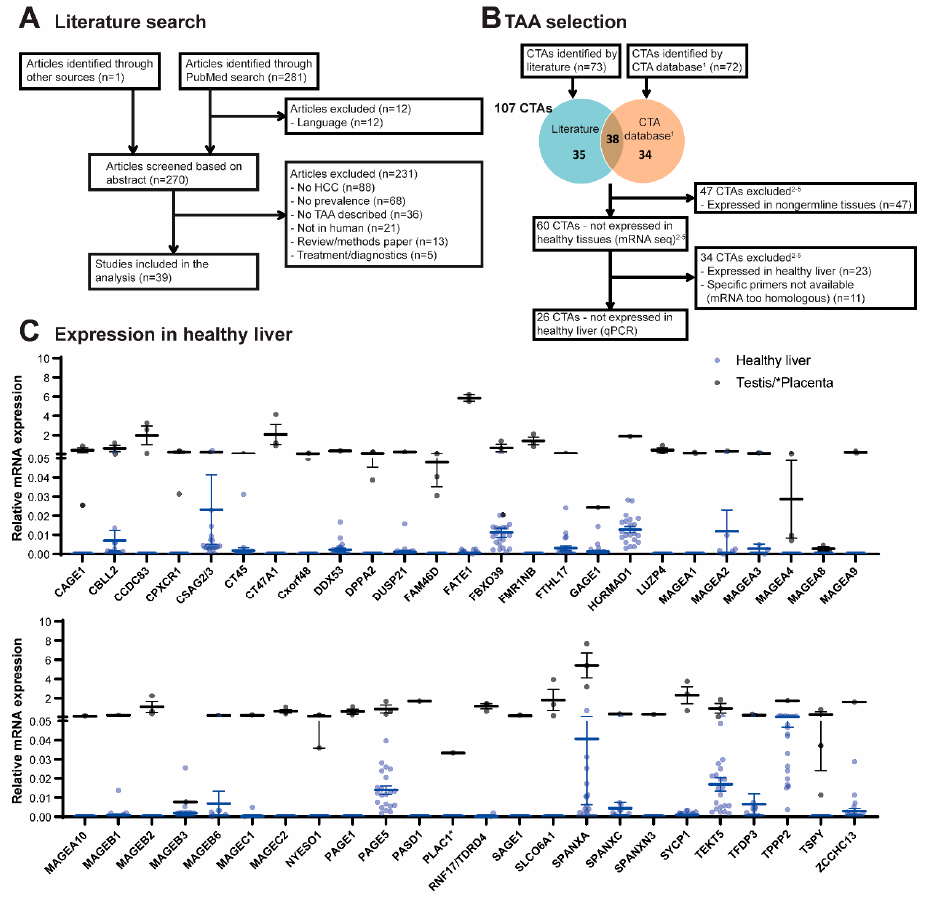
Figure 1. Selection of CTAs. ( A , B ) Study Flow Diagram. ( C ) Relative mRNA expression of selected CTAs in healthy donor livers ( n = 21) in blue and in the respective positive control tissues in black. Control tissues were: placenta (for PLAC1; n = 1) or testis (all other CTAs; n = 1–3). 1 http://www.cta.lncc.br/ 4 October, 2018, 2 Hofmann, et al. 3 FANTOM consortium, 4 HPA consortium, 5 GTEx consortium [9,14,15].